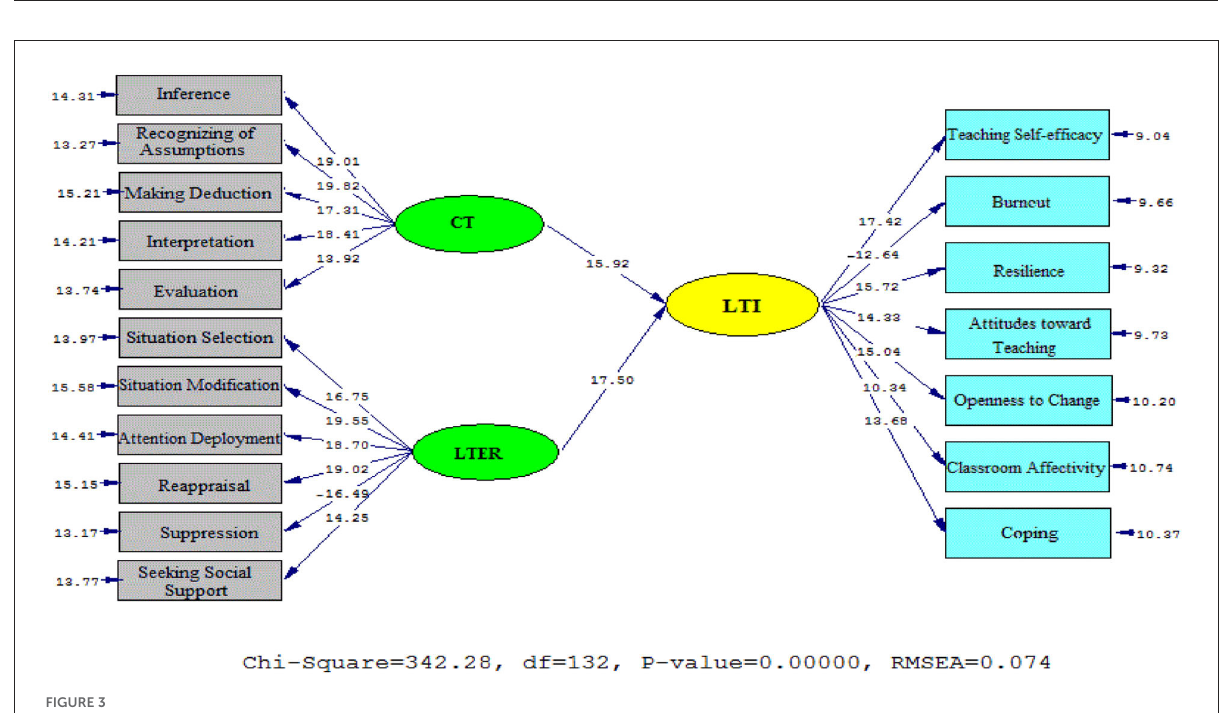
FIGURE3 The T values for path coefficient significance (model